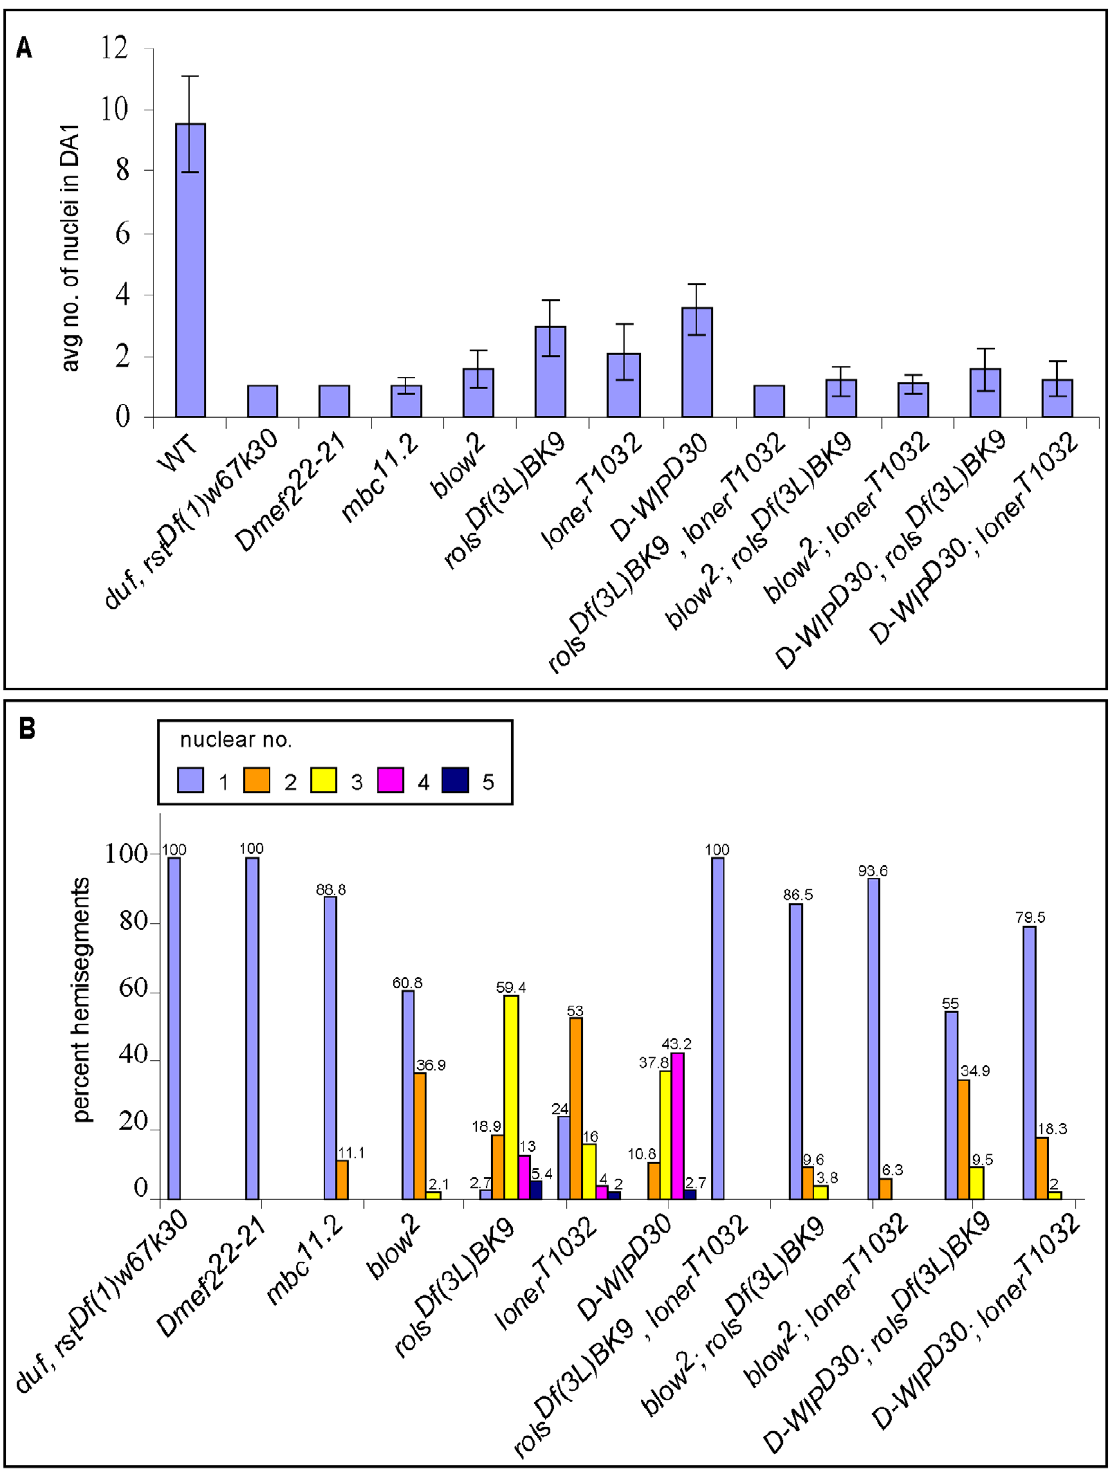
Figure 6. Fusion efficiency is compromised in double mutant backgrounds. Average number of Eve positive nuclei in the listed mutants, at late stage 15-early stage 16. 45 hemisegments (A2–4, 15 embryos) were counted. (A). Distribution of nuclear numbers in the listed mutants at late stage 15-early stage 16 (B). Fusion efficiency is significantly compromised in the double mutants compared to the single mutants (Students t-test P , 0.001). Numbers above each bar indicate percent hemisegments for each genotype.